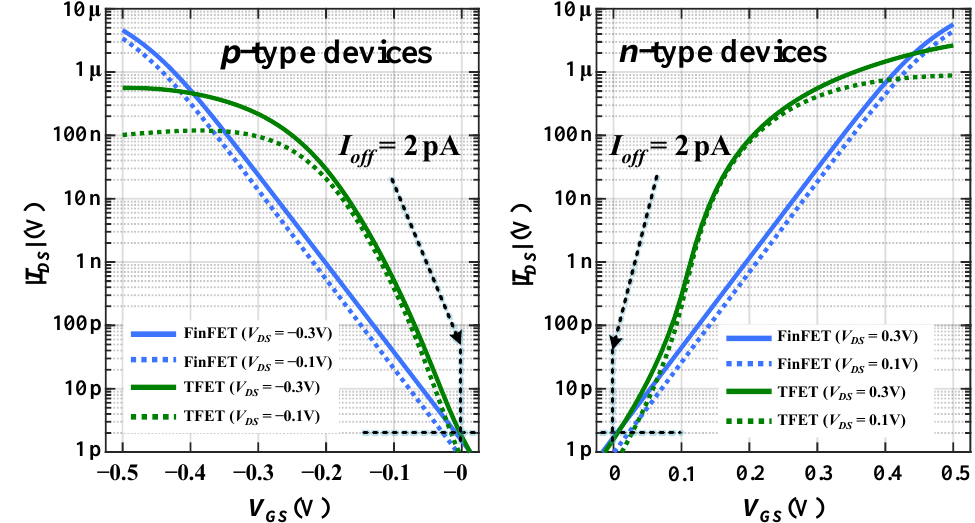
Figure 1. Sketch of the device architecture for: n - and p -type ( a ) TFETs and ( b ) FinFET, and ( c ) STT DMTJ with magnetization orientation at high (R H ) and low (R L ) resistance states along with the electron flow for R L → R H and R H → R L switching.